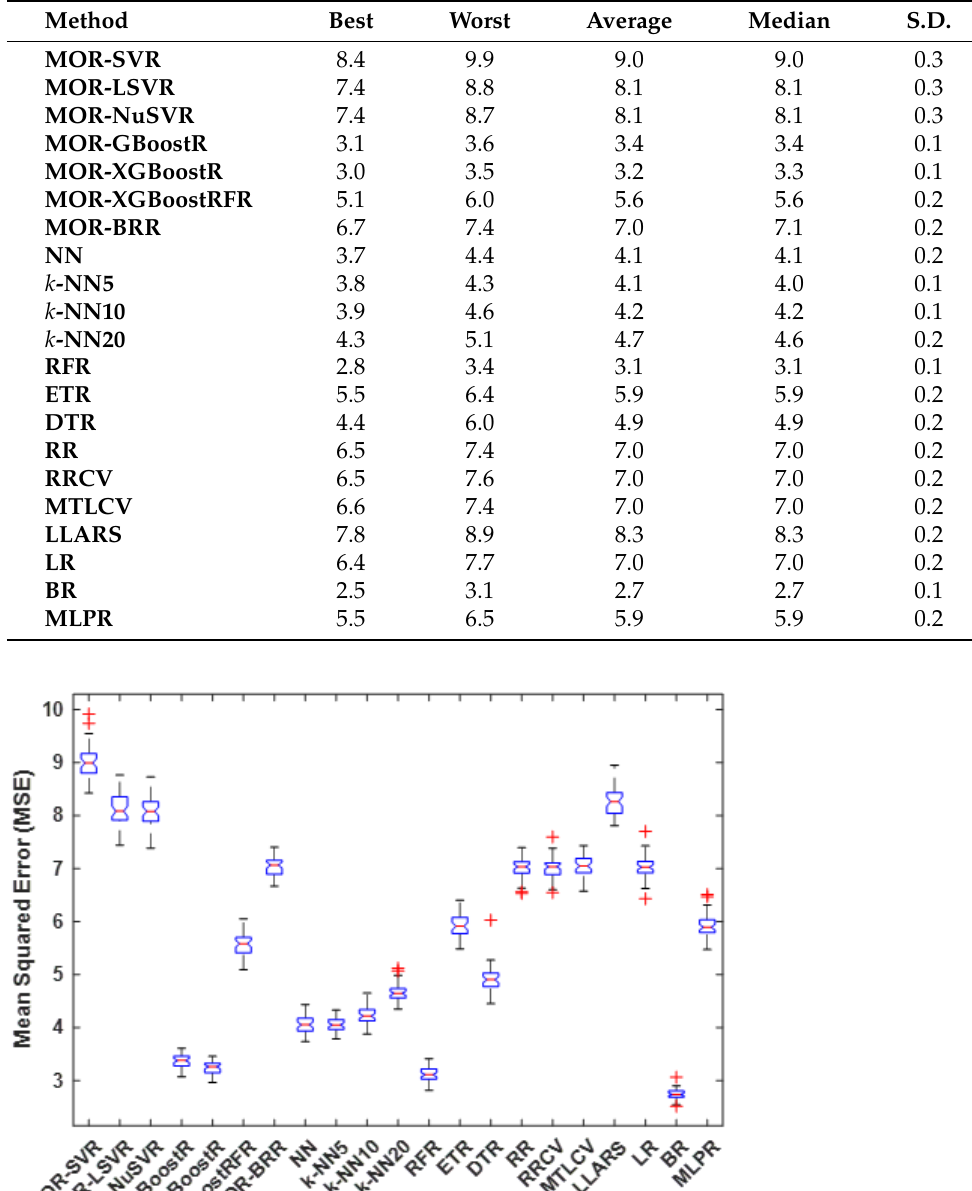
Table 10. Mean squared error (MSE) for all methods over 50 statistical runs (the first stage).